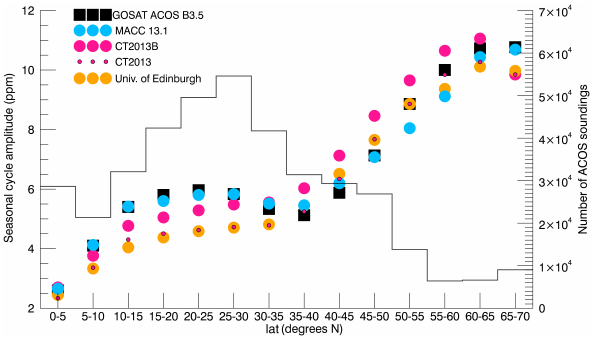
Figure 7. Latitudinal dependence of the seasonal cycle amplitude for bias-corrected ACOS B3.5 soundings and for three models re- sampled at the satellite soundings. For CarbonTracker, we show both CT2013 and CT2013B results, their difference being a major correction in the TM5 transport model. The left vertical axis shows the seasonal cycle amplitude in ppm, while the right vertical axis indicates the number of soundings that fall within each 5 ◦ latitude band (black line).